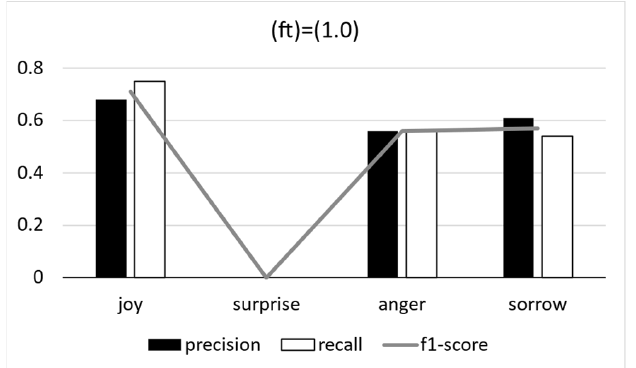
11 of 17 Table 4. Parameters used for pretraining and training. Training Model/Algorithm